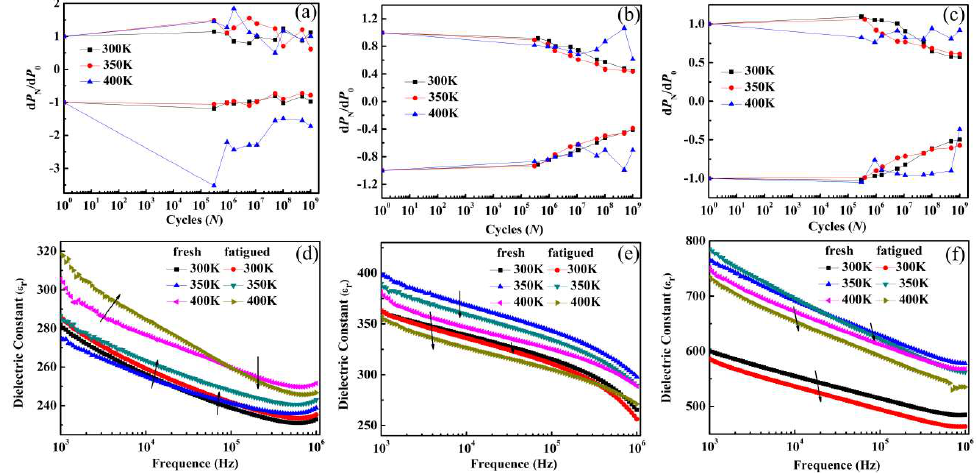
Figure 4. Plots of polarization fatigue curves, ferroelectric hysteresis, and dielectric constant ( ε r ) vs. frequency at both fresh and fatigued condition: ( a , d ) for BTM; ( b , e ) for BNTM05; ( c , f ) for BNTM85.